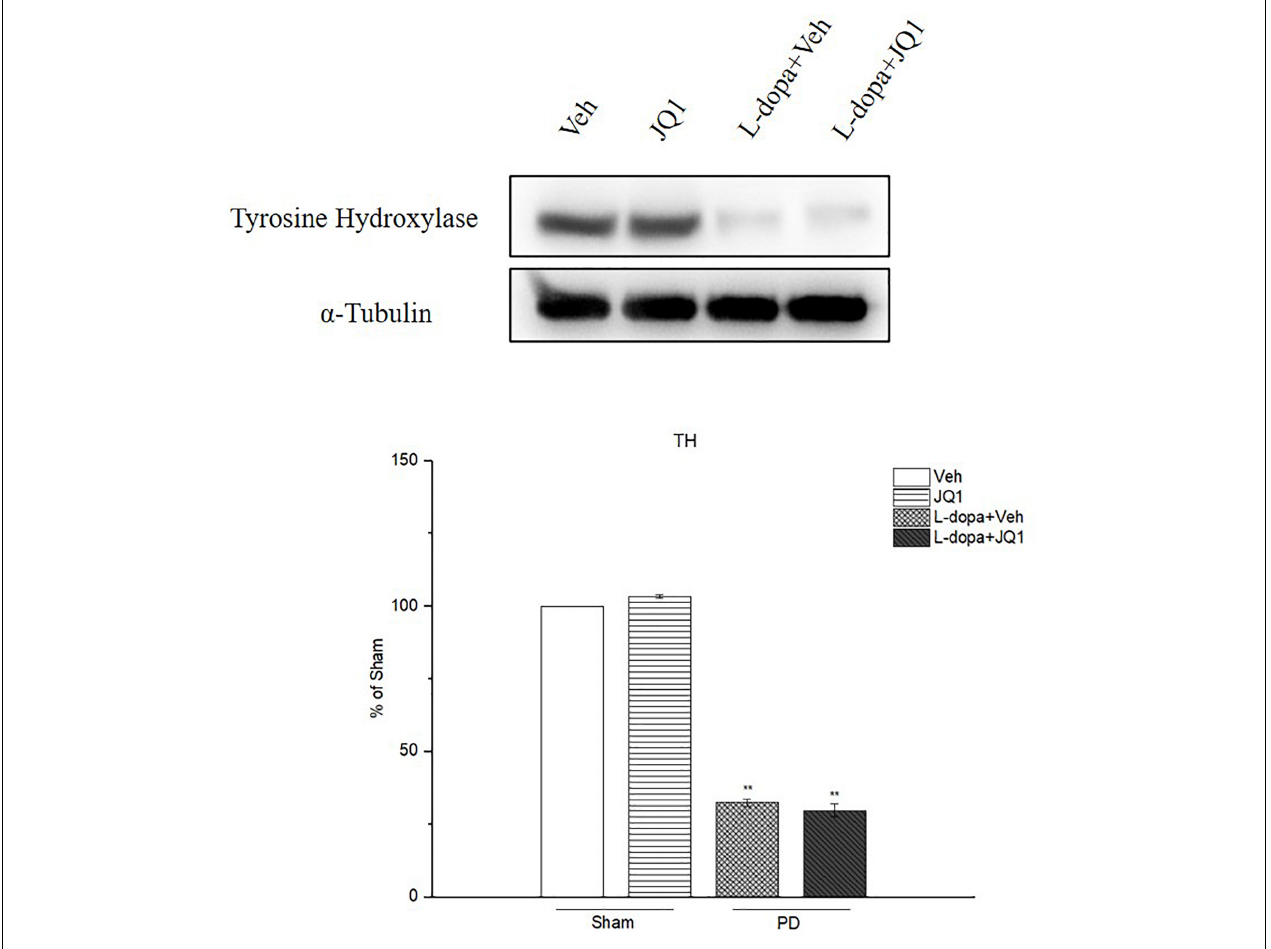
FIGURE 4 | Changes in the TH protein level extracted from the saline- or 6-OHDA-lesioned striatum after 21 days of administration. Both L-dopa treatment group and L-dopa + JQ1 treatment groups showed a significant reduction in the TH protein level in the rats’ ipsilateral striatum after 21 days of treatment ( p < 0.001 vs. Veh group). No difference was found in the TH protein level between L-dopa and L-dopa + JQ1 treatment groups ( p > 0.05). TH levels expression relative to α -tubulin levels. The data are expressed in terms of mean ± SD and as a percentage of the Veh group. ** p < 0.001 vs. Veh group ( n = 3 per